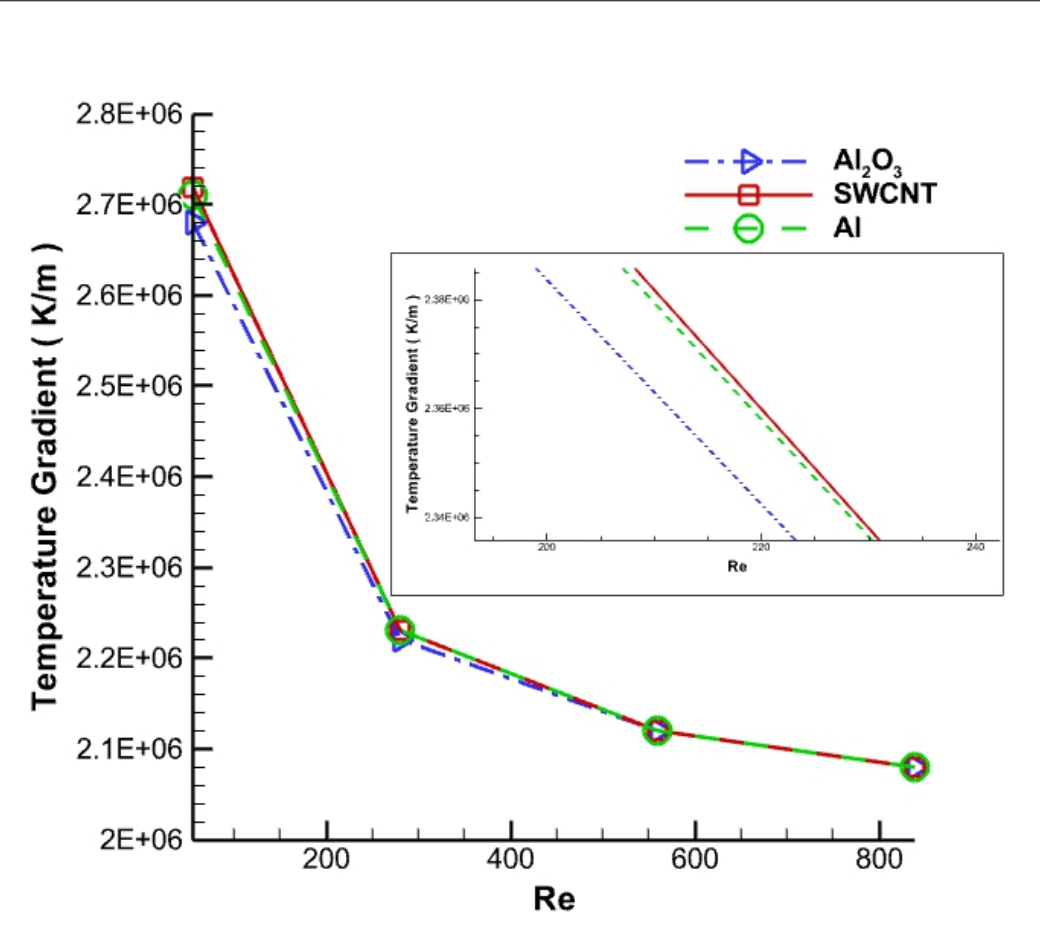
Figure 15. Variation in the temperature gradient of the cutting tool with respect to Reynolds num ‐ ber.